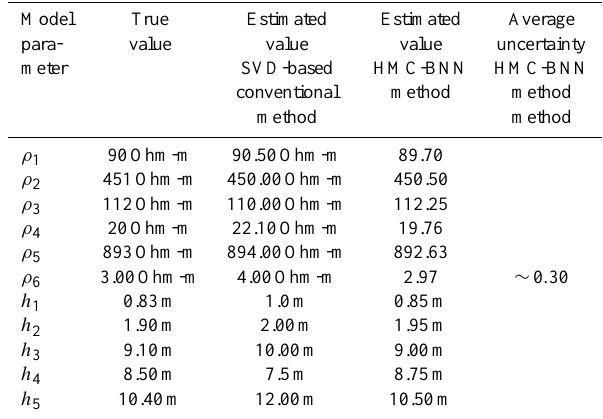
Table 1. Estimation of model parameter of synthetic data set cor- rupted with 5% correlated red